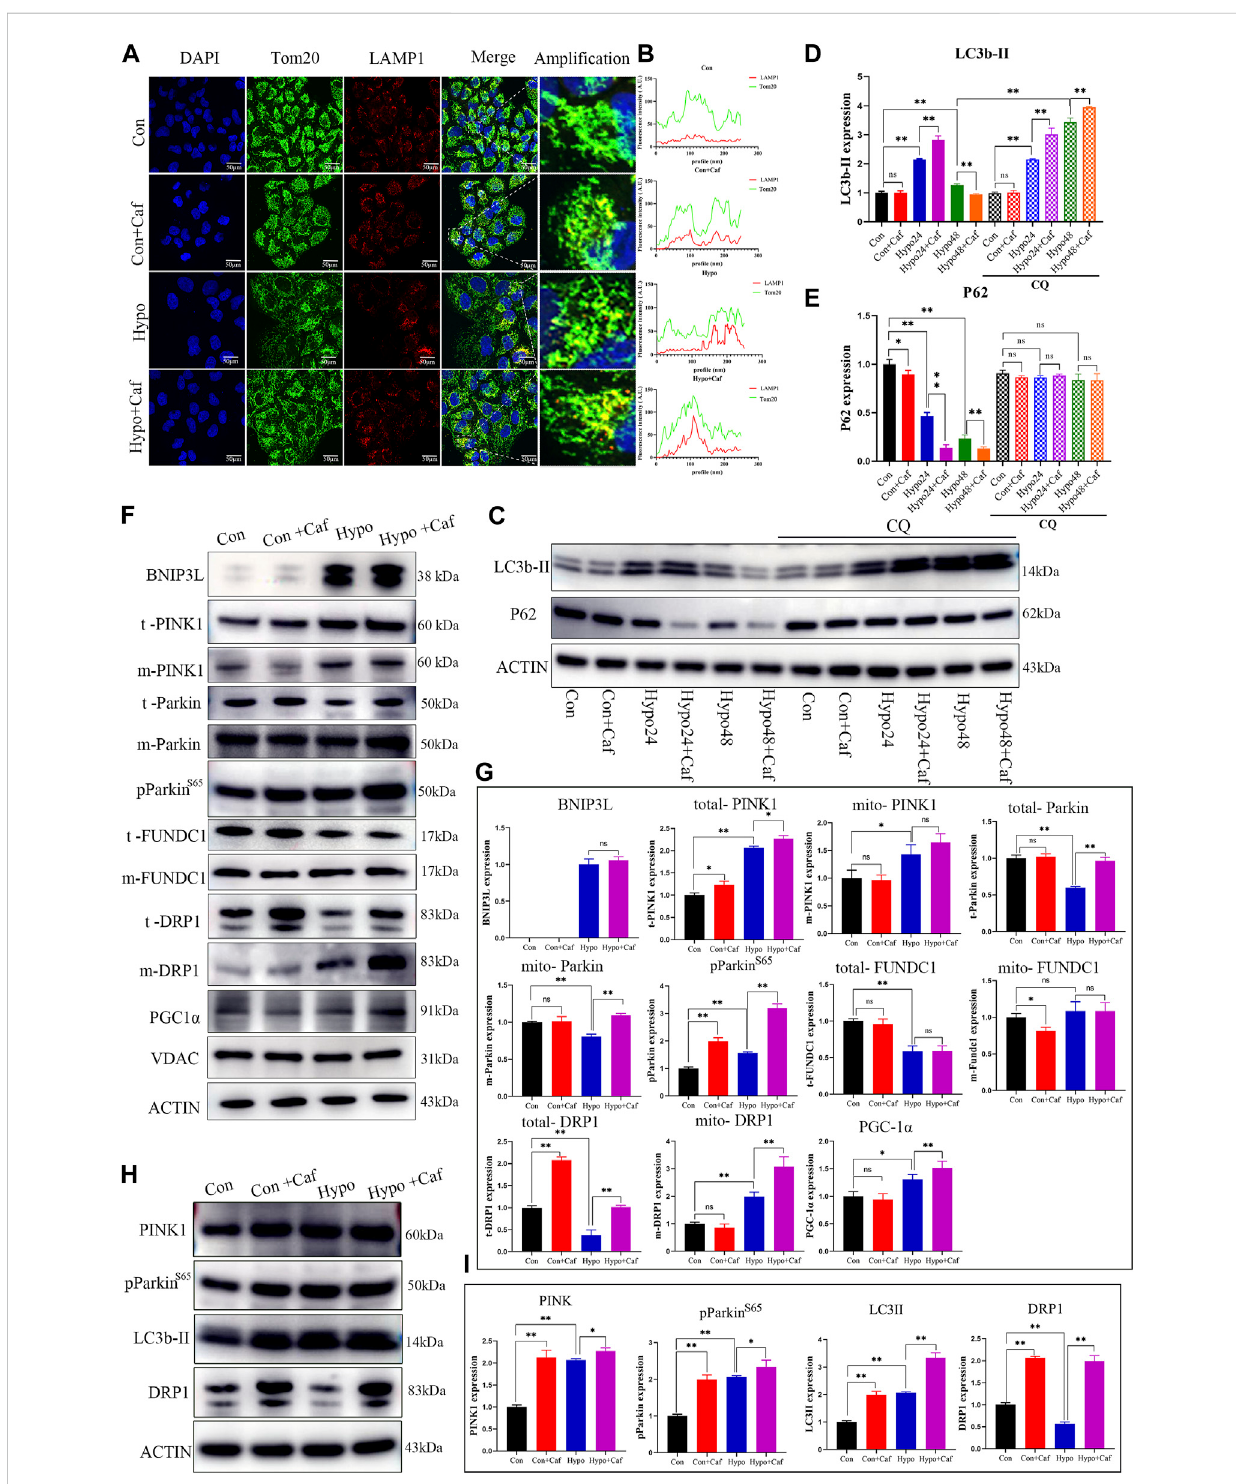
FIGURE 6 Caffeine mediated mitochondrial quality control process. (A, B) (A) The fl uorescence images showed the colocalization of mitochondria (green fl uorescence) and lysosomes (red fl uorescence). The merged fl uorescence (yellow) re fl ected mitophagy, and caffeine increased mitophagy in hypoxia. (Scale bars, 100 μ m). (B) Quanti fi cation of colocalization. (C – E) Representative Western blot images and summarized data of LC3b-II and P62 following hypoxic treatment for 24h/48 h in the absence or presence of chloroquine (50 μ M). LC3-II was signi fi cantly increased at the early stage of hypoxia treatment (24 h) and then gradually decreased (48 h), while caffeine further ampli fi ed the LC3-II changes. P62 protein expression level was downregulated in hypoxia, and caffeine enlarged the degree of decrease. CQ blocked the role of caffeine in the enhanced autophagic fl ux. (F, G) Representative Western blot images and summarized data of BNIP3L, t- PINK, m- PINK, t- Parkin, m- Parkin, pParkin (S65), t- FUNDC1, m- FUNDC1, t- DRP1, m- DRP1and PGC1 α in AT1 cells. VDAC was the internal reference of mitochondrial membrane proteins, and ACTB was the internal reference of totalproteins. (H,I) RepresentativeWesternblotimagesandsummarizeddataofPINK,pParkin(S65),LC3II,andDRP1proteinsoflungs.ACTBwasusedas an internal